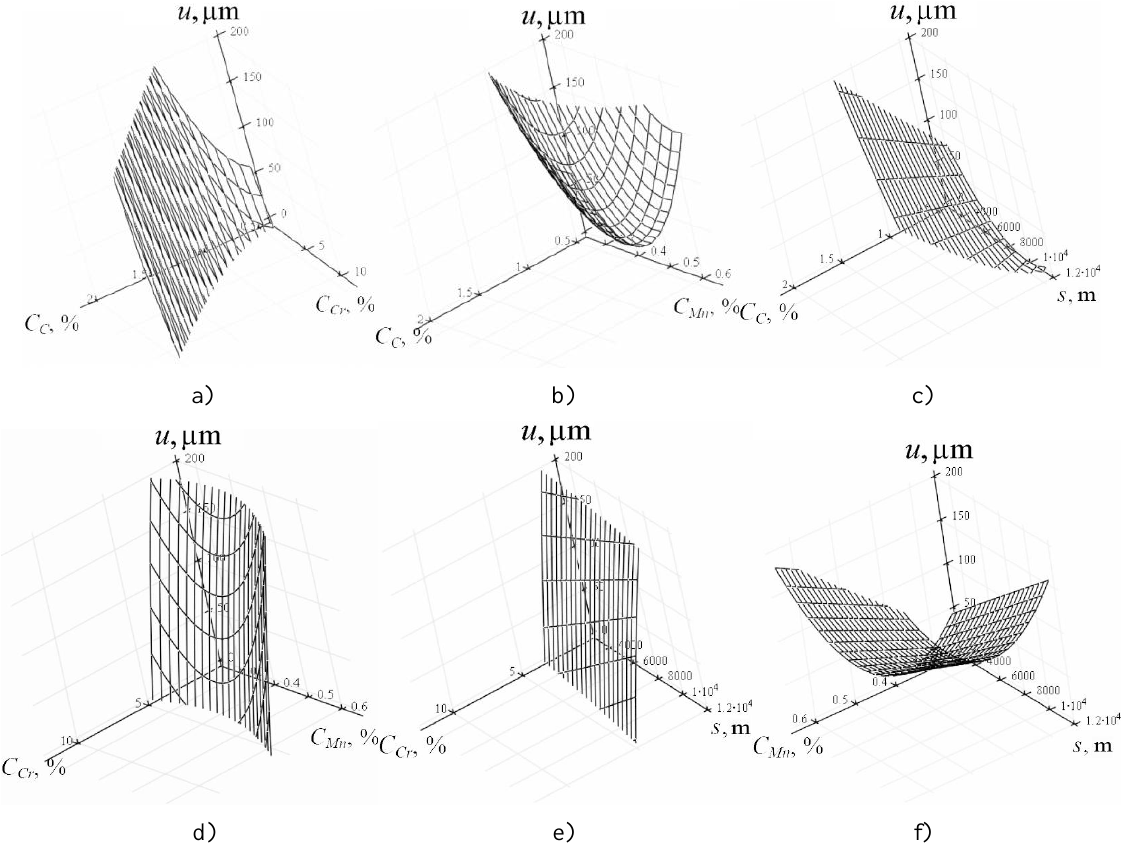
Fig. 1. The response surfaces of the objective function - wear of the hardened auger u in the planes of the impact parameters (а) – u = f ( C C , C Cr ), (b) – u = f ( C C , C Mn ), (c) – u = f ( C C , s ), (d) – u = f ( C Cr , C Mn ), (e) – u = f ( C Cr , s ), (f) – u = f ( C Mn , s